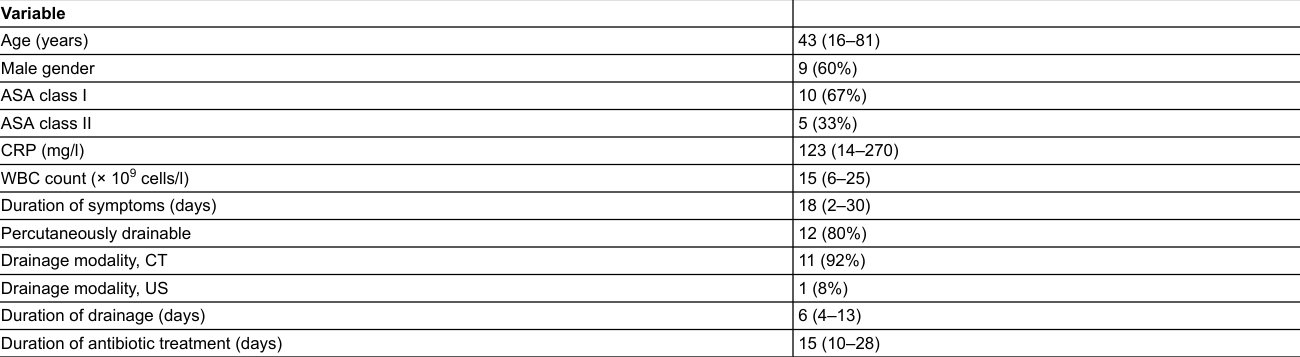
Table 1: Demographic data and baseline characteristics for patients with perityphlitic abscess formation (n = 15).